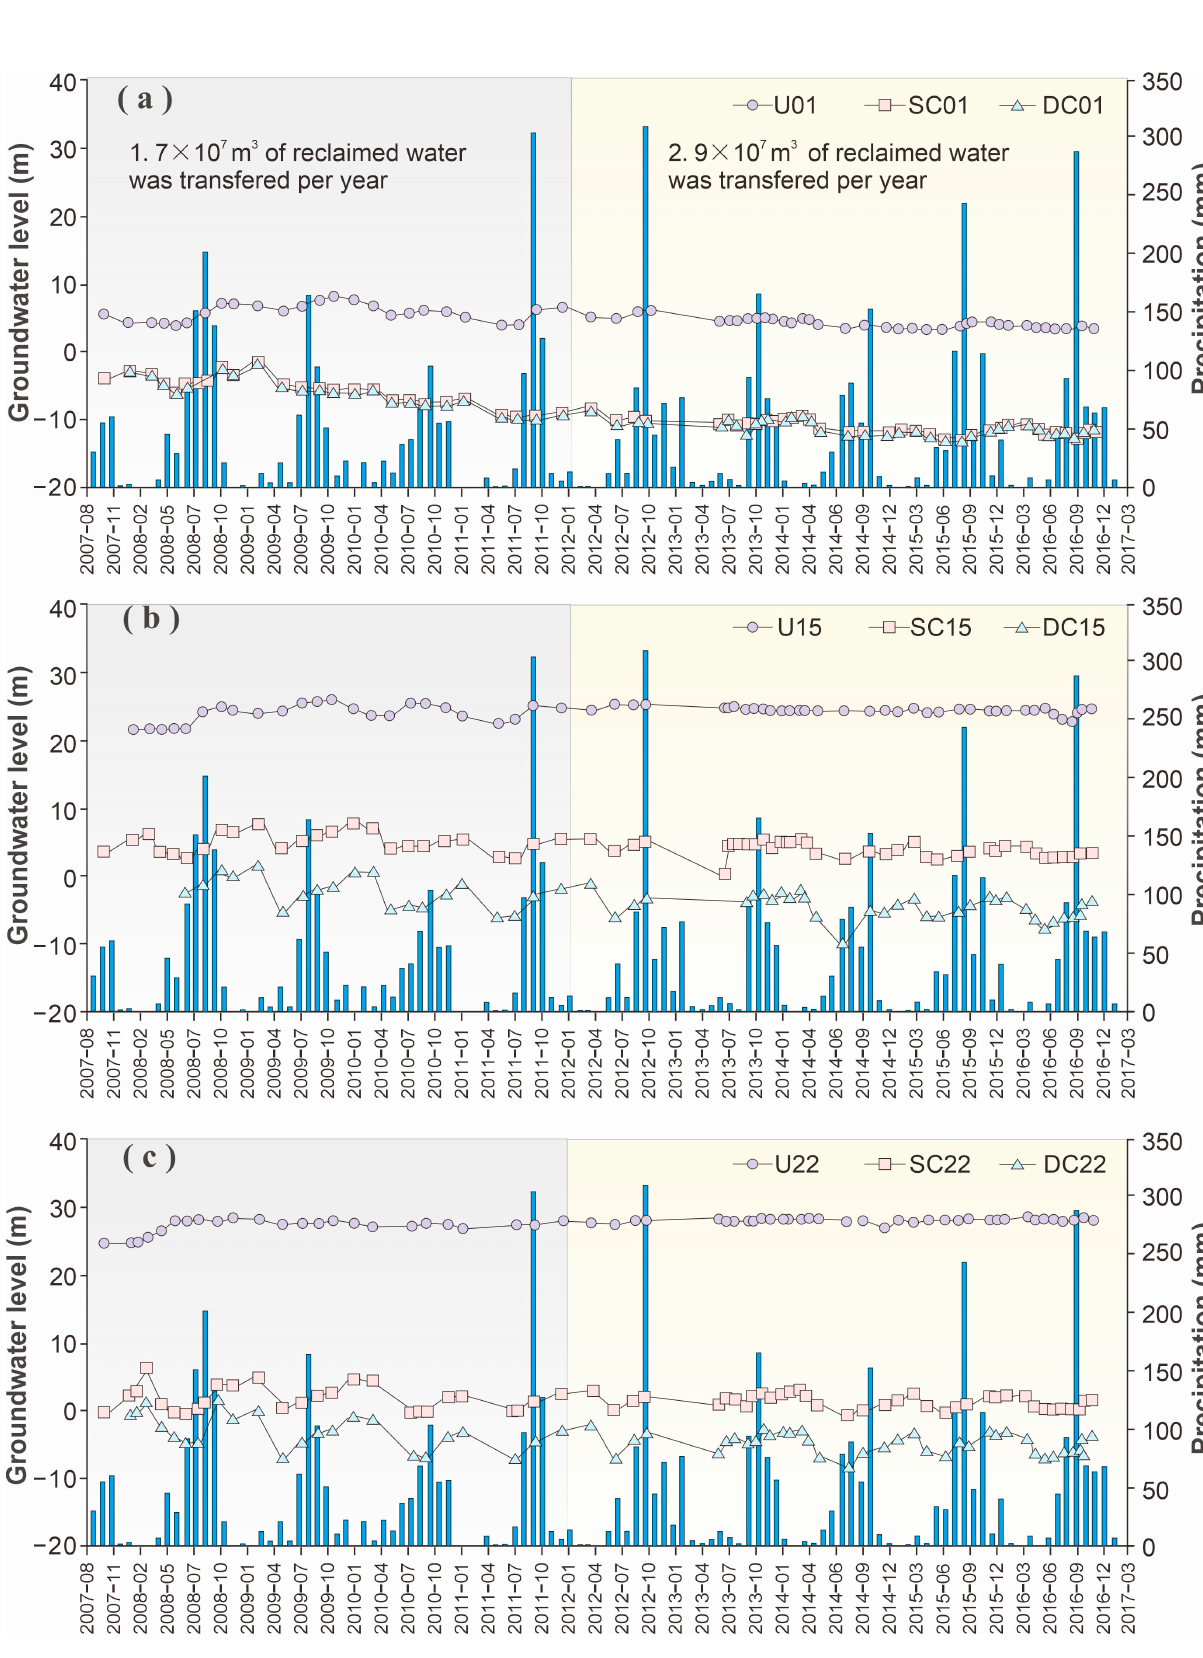
Figure 4. Hydrographs for well groups located 20 m to river channel with screened sections in 30-m, 50-m and 80-m depth aquifers during 2007–2016, at ( a ) anti-seepage reach, ( b ) intermittent intake reach, and ( c ) perennial intake reach. “U”, “SC”, and “DC” as prefixes of the sample labels represent groundwater from the 30-m, 50-m, and 80-m depth aquifers,